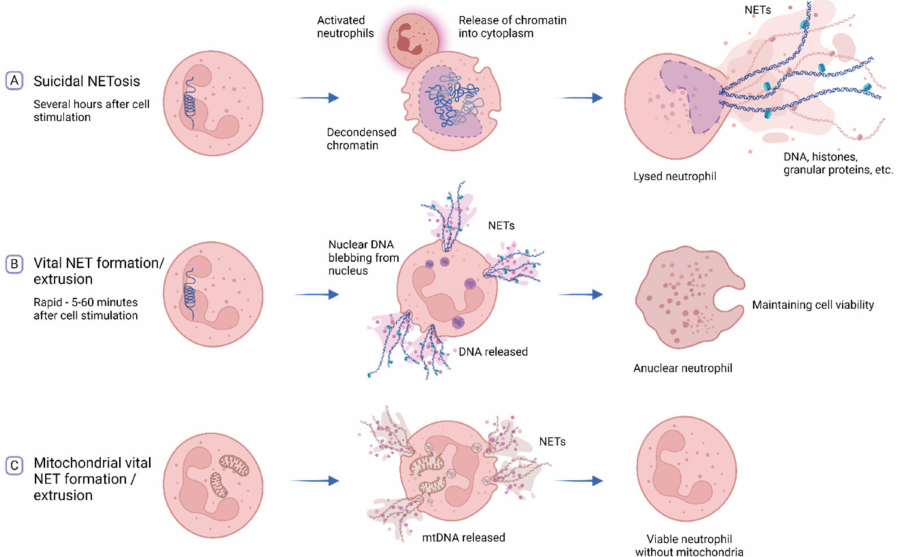
Figure 6. Mechanisms of NET formation. ( A ) Suicidal NETosis occurs over several hours and involves the decondensation of chromatin in activated neutrophils leading to the release of chromatin into the cytoplasm. Subsequently, the cell membrane is ruptured and chromatin is released from the lysed neutrophil into extracellular space. ( B ) Vital NET formation/extrusion is a rapid process occurring within 60 min of cell stimulation where vesicles containing nuclear DNA are fused with the plasma membrane and chromatin is released entirely, leaving anuclear neutrophils. These cells maintain their viability; therefore, this type of NET formation is best categorized as NET extrusion rather than NETosis, which implies that the NET-forming cells are lysed. ( C ) Mitochondrial vital NET formation/extrusion is a secondary form of vital NET formation in which mitochondrial DNA is released as NETs after the rupture of mitochondrial membranes, leaving viable neutrophils lacking